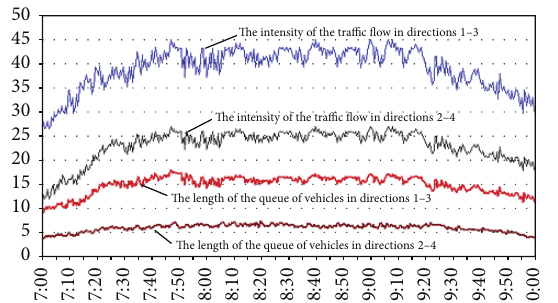
Figure 4: The results of the simulation modeling of the adaptive traffic control